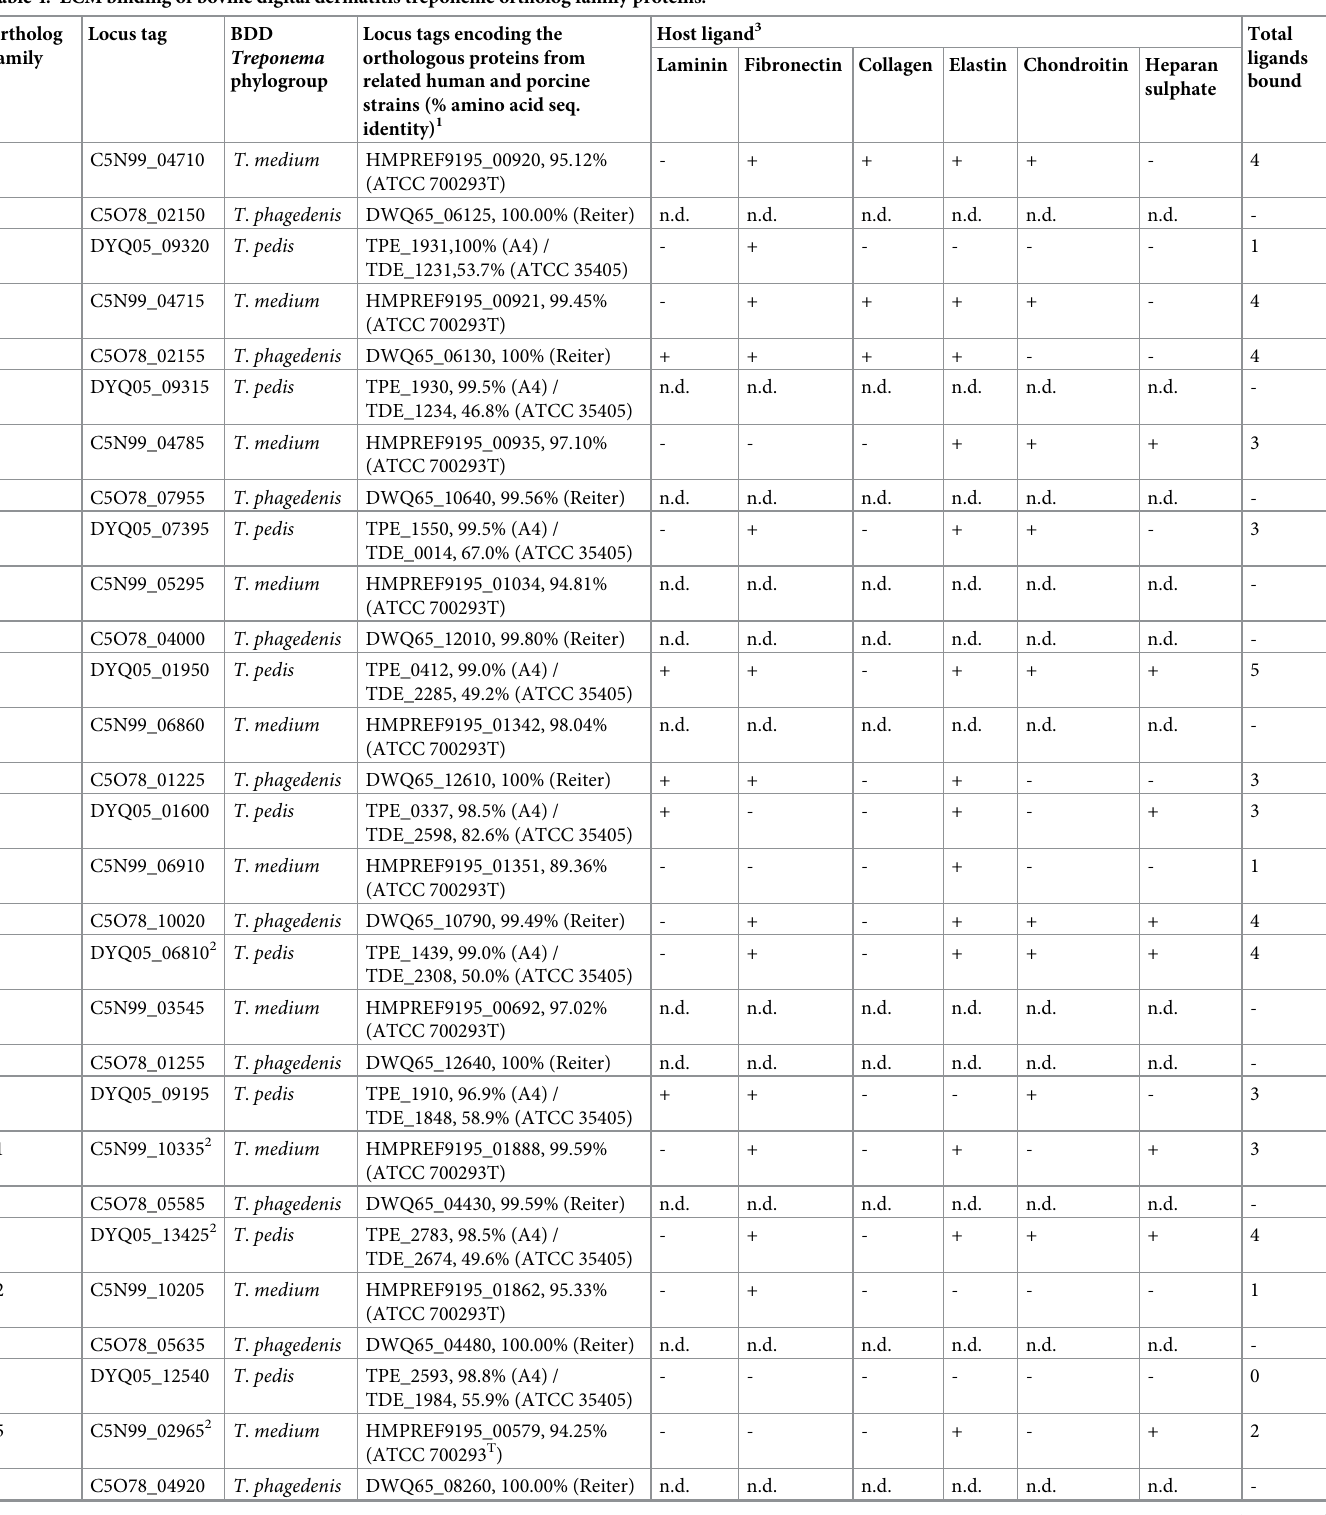
Table 4. ECM binding of bovine digital dermatitis treponeme ortholog family proteins. Ortholog Locus Family